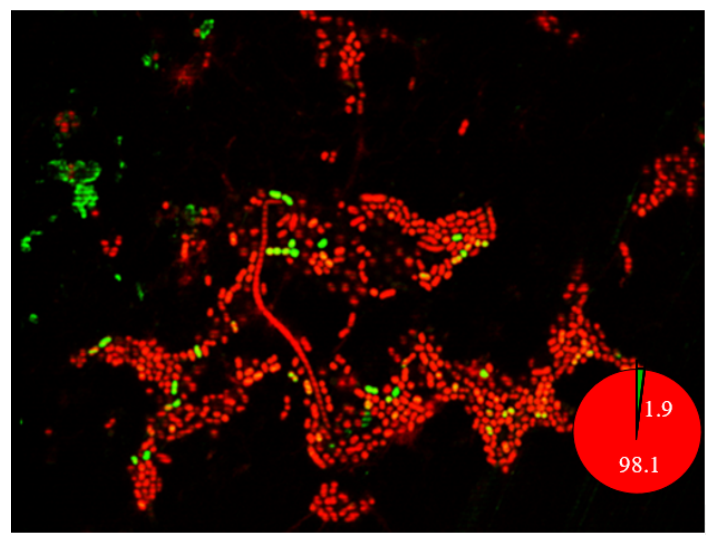
Figure 2. Detection of persisters from biofilm and planktonic cells of A. baumannii ST 1894. The number of viable biofilm and planktonic cells at different time points after treatment with 2048 μ g/mL ciprofloxacin. Red solid and dotted lines represent untreated biofilm and planktonic cells, respectively. Blue solid and dotted lines represent biofilm and planktonic cells treated with ciprofloxacin, respectively.